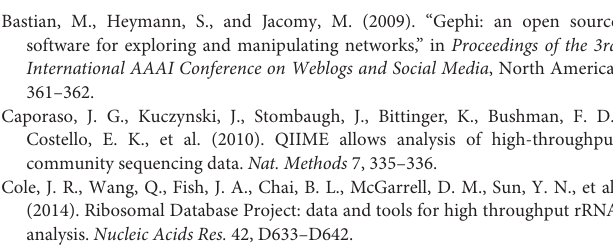
Supplementary Figure 1 | Samples grouped by microbial community composition and environmental conditions. Supplementary Figure 2 | Simplified networks by grouping nodes belong to the same taxonomic affiliation. Supplementary Figure 3 | Response ratio analysis revealing taxa enriched in downstream networks as compared to upstream. Supplementary Table 1 | Global properties for overall upstream and downstream networks regardless of